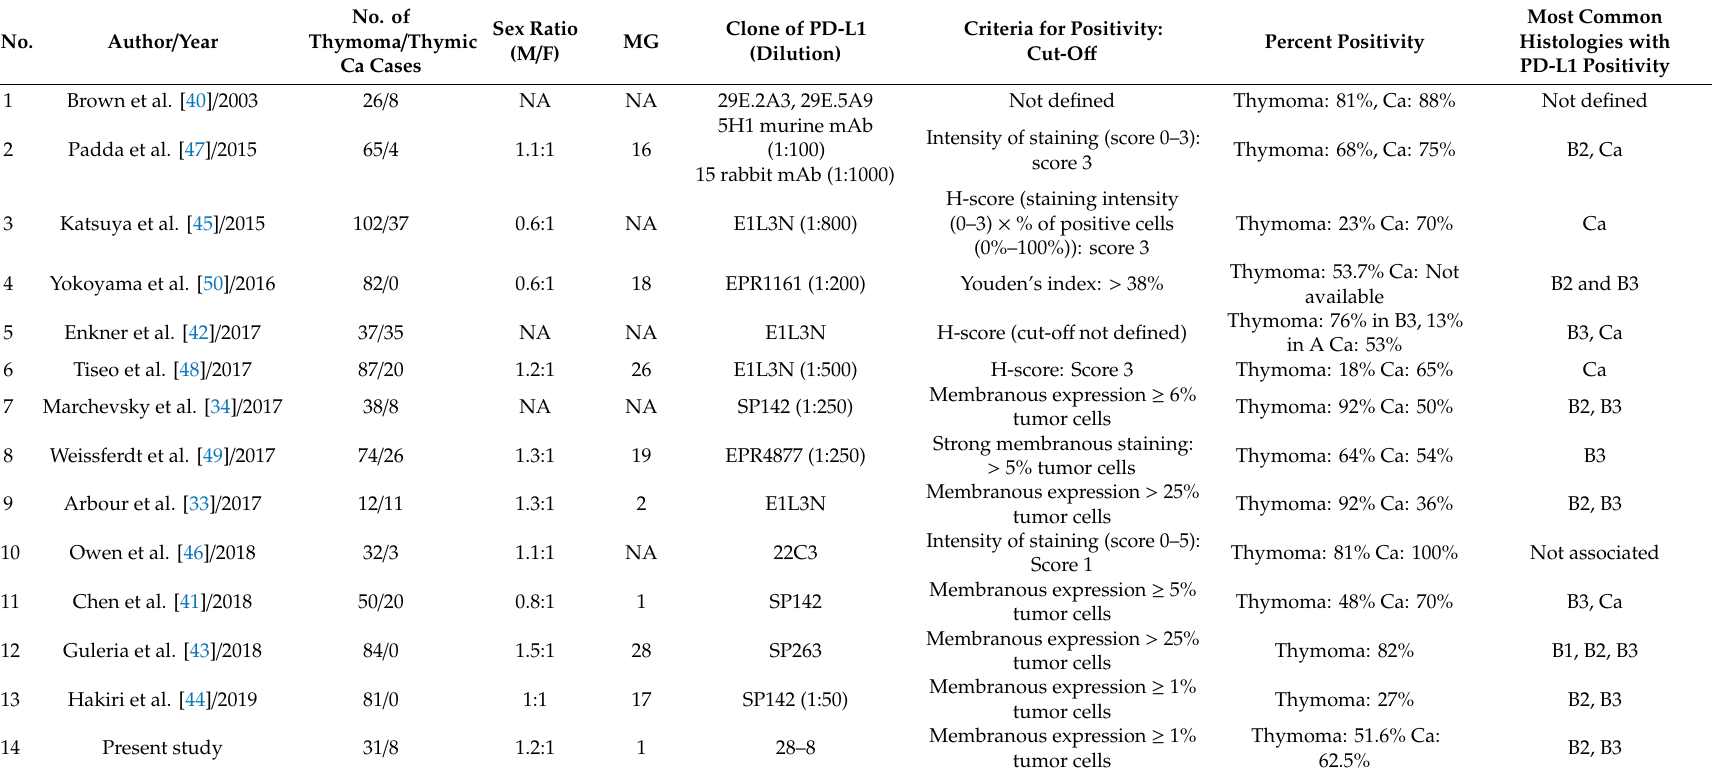
Table 2. Summary of previously published studies of PD-L1 immunohistochemistry in